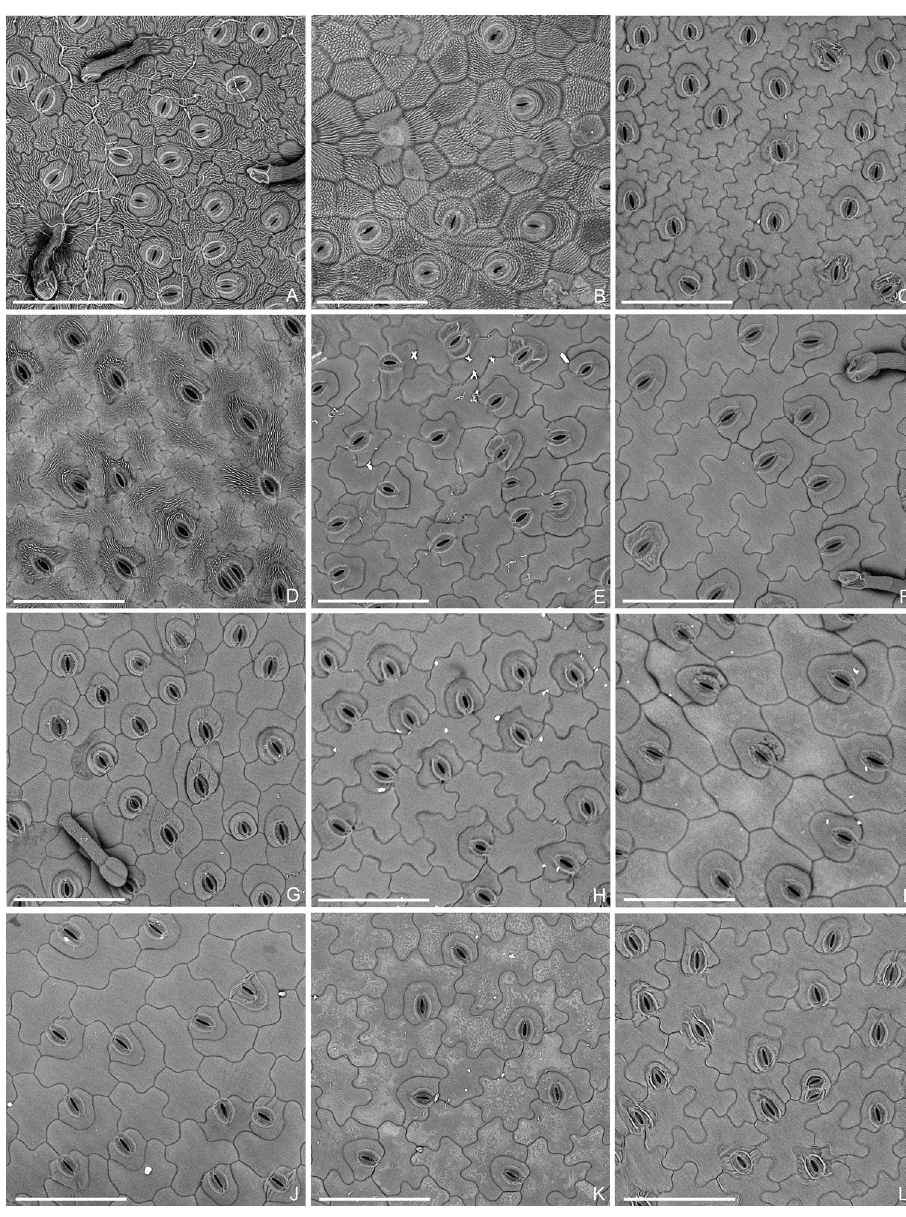
Figure 4. Scanning electron micrographs of lower epidermis. A–D Tashiroea clade, showing presence of furrowed surface sculpture: A T. amoena ( Y. Liu 571 ) B T. nudipes ( Y. Liu 435 ) C T. villosa ( Y. Liu 568 ) D T. yaeyamensis ( Y. Liu 631 ) E–L Bredia clade, showing absence of furrowed surface sculpture E B. du- lanica ( Y. Liu 565 ) F B. gibba ( Y. Liu 566 ) G B. gracilis ( Y. Liu 457 ) H B. hirsuta ( Y. Liu 563 ) I B. longira- diosa var. pulchella ( Y. Liu 485 ) J B. repens ( Y. Liu 558 ) K B. tuberculata ( Y. Liu 629 ) L B. yunnanensis ( Y. Liu 627 ). Scale bars: 100